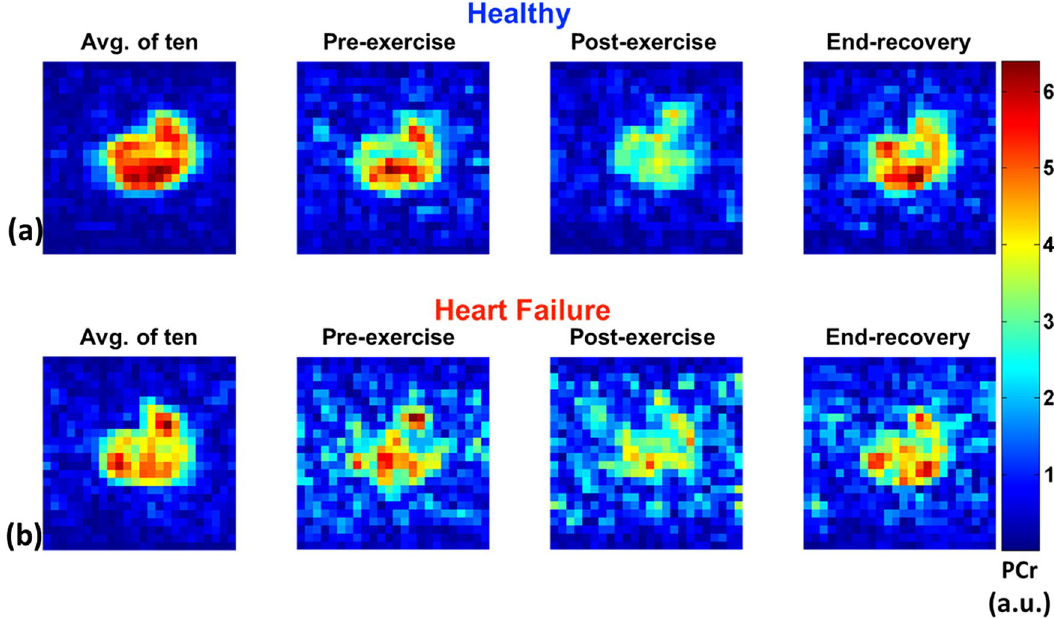
Figure 3. PCr imaging. Representative cross-sectional PCr image of the calf muscle from a volunteer (top) and a HF-patient (bottom), obtained from pre, after exercise and end of recovery respectively. The low SNR of HF-patient image is due to the low PCr concentration of the calf muscles compared to volunteer. The first column shows images with 10 averages to increase SNR.